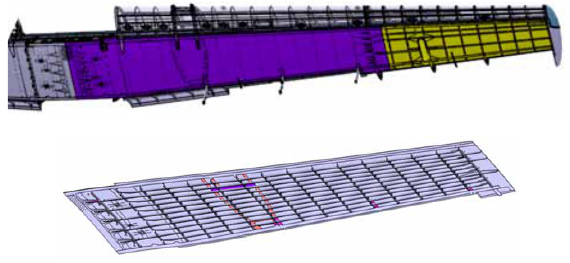
Fig. 2. Detail of the initially designed milled lower wing panel